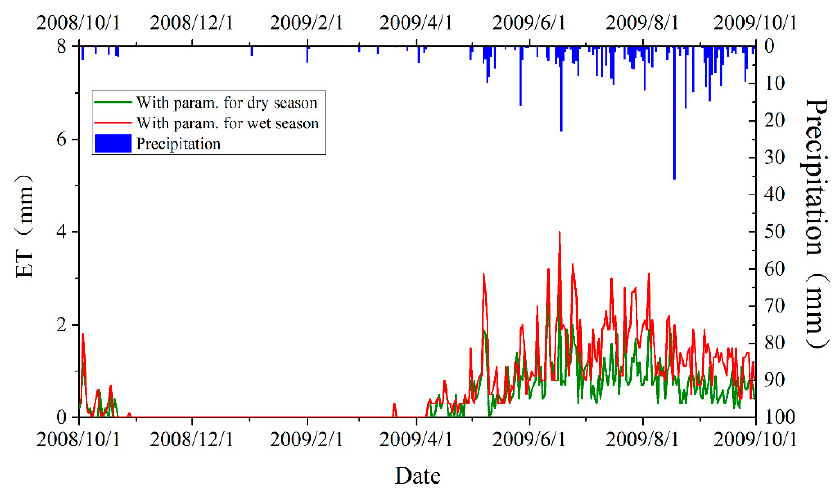
Figure 10. Simulated evapotranspiration (ET) using the parameters calibrated for dry seasons and for wet seasons,